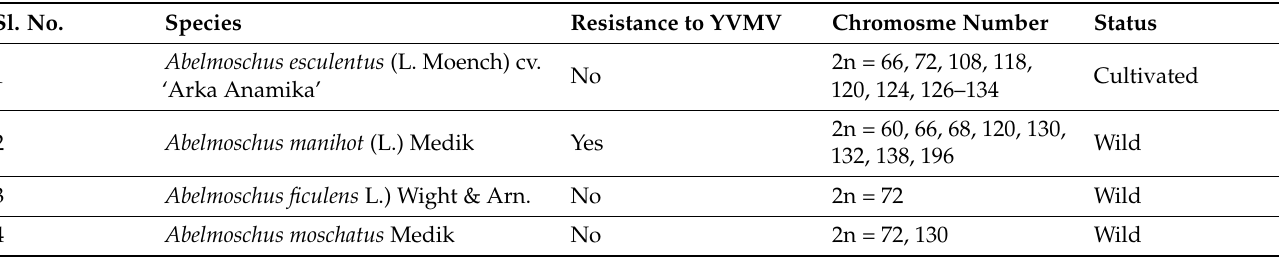
Table 1. Abelmoschus species used for hybridization